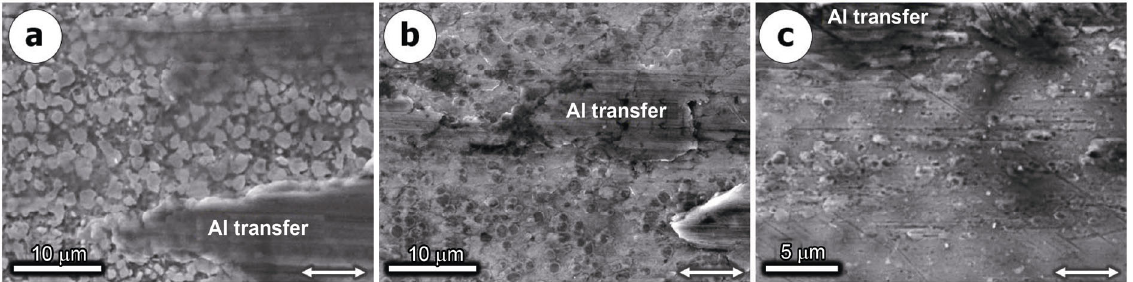
Fig. 14 SEM micrographs of the surface of the (a) mirror-polished tool steel O and (b) flattened aluminium topography obtained from the polymer lubricated test ( ↔ indicates the sliding direction).